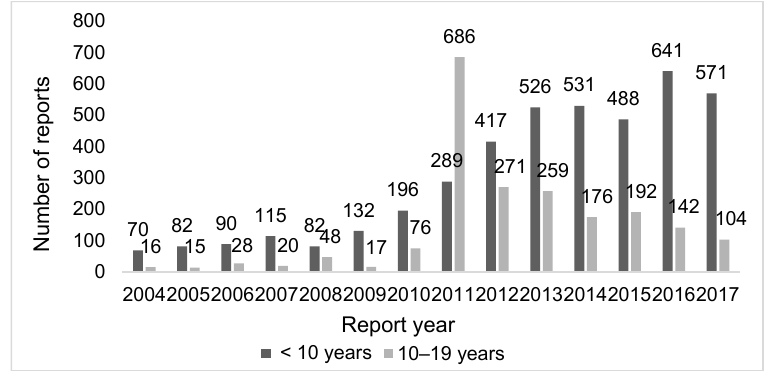
Figure 1. Annual AEFI reports in children in Japan for the period 2004–2017 according to age group.